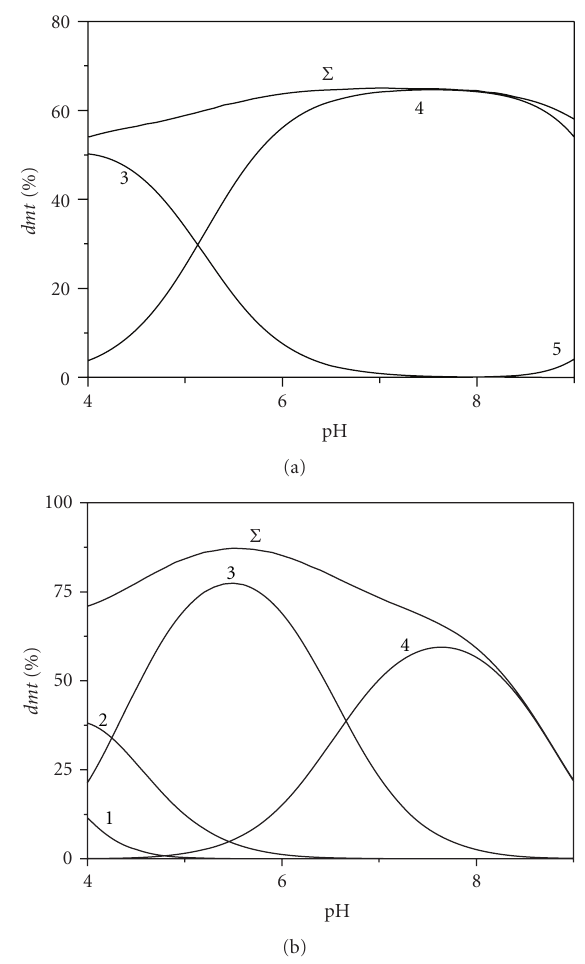
Figure 1: Distribution diagrams of dimethyltin(IV)/amine species versus pH in NaCl aq at t = 25 ◦ C. Diagrams: (a) putrescine; (b) polyethyleneimine (considered as a simple diamine). Species: (1) MLH 3 ; (2) MLH 2 ; (3) MLH; (4) ML; (5) ML 2 . Charges omitted for simplicity. Experimental conditions: C dmt = 0 . 003 mol L − 1